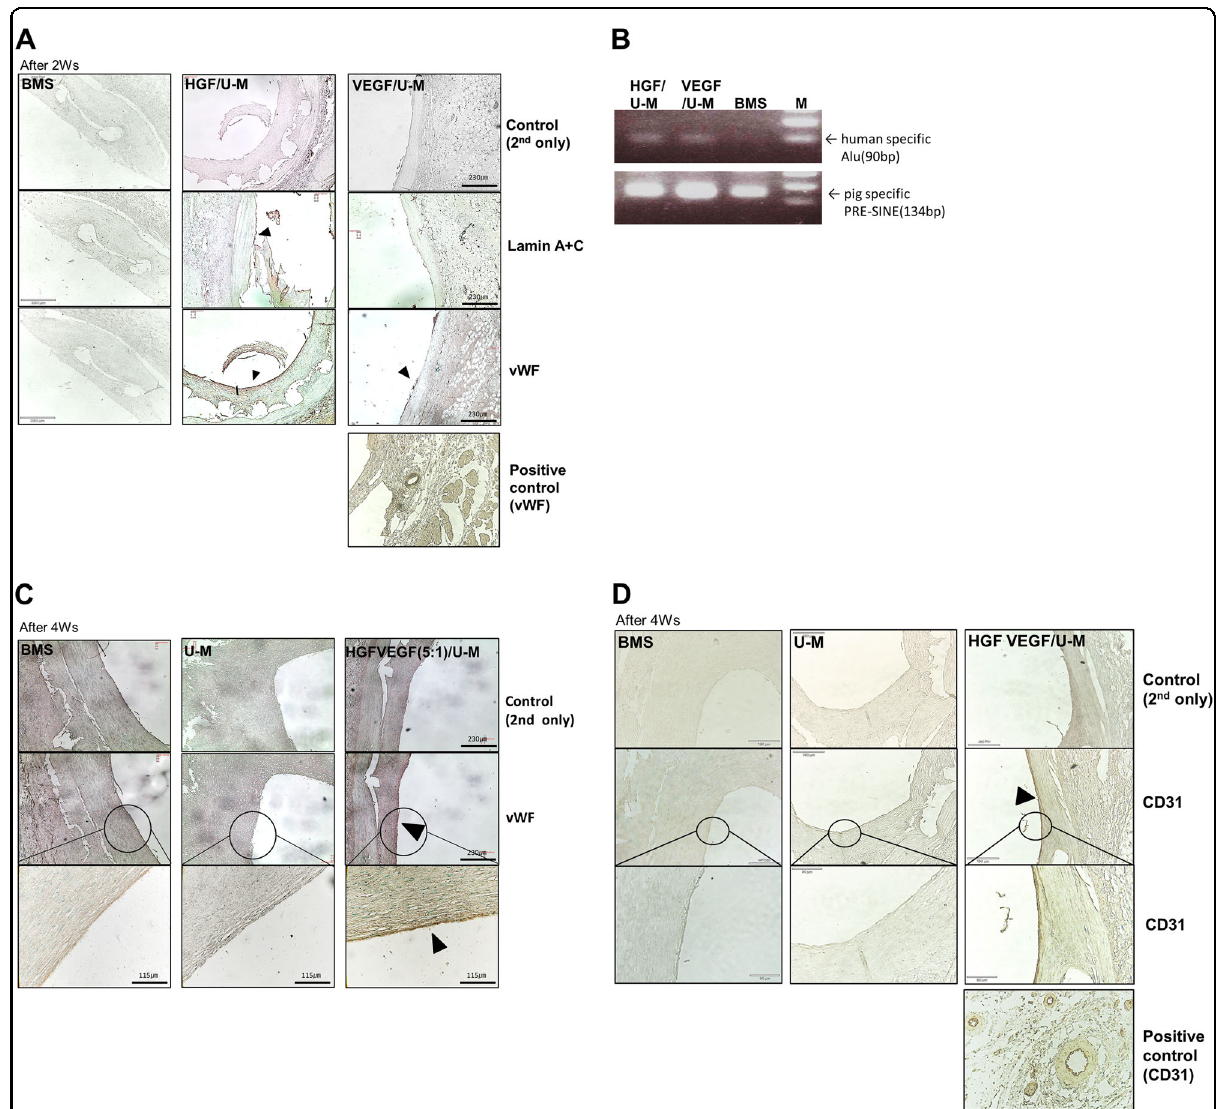
Fig. 6 Re-endothelialization was observed in coronary arteries with transplanted stents coated with HGF + VEGF/U-Ms and human MSCs in the swine model. a The coronary arteries transplanted with stem cell-loaded stents were sectioned and stained using anti-vWF (1:200) and anti- Lamin A + C (1:200) antibodies. The samples were harvested 2 weeks after transplantation. b Human-speci fi c Alu was detected using RT-PCR in coronary arteries 2 weeks after transplantation. c Anti-vWF immunostaining showing the re-endothelialized portion of the coronary arteries 4 weeks after transplantation for the stents coated with the HGF + VEGF/U-Ms. d Anti-CD31 (1:50) immunostaining showing the re-endothelialized region of the coronary arteries. N =